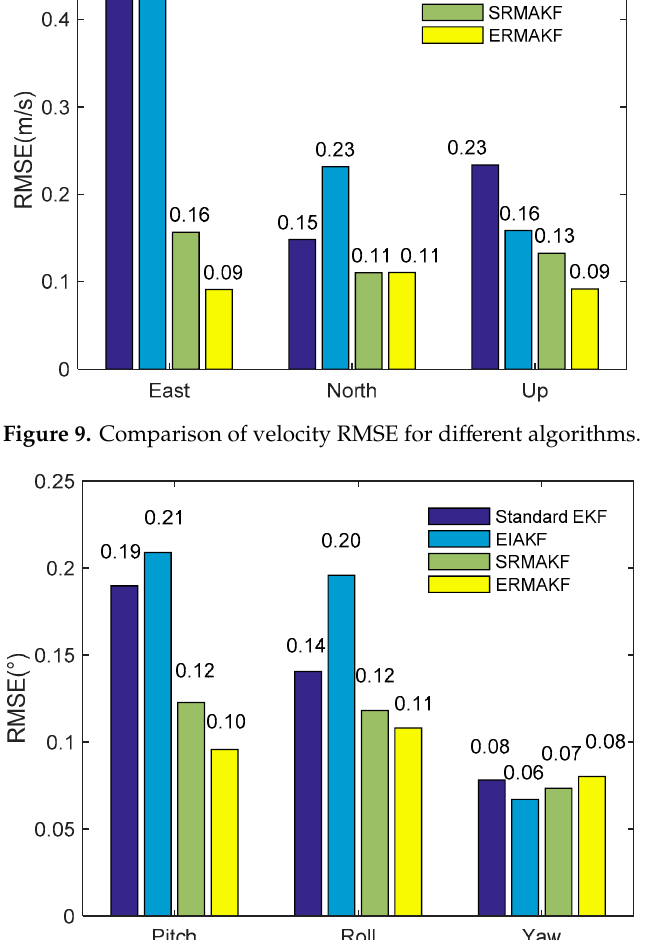
Figure 10. Comparison of attitude RMSE for different algorithms.